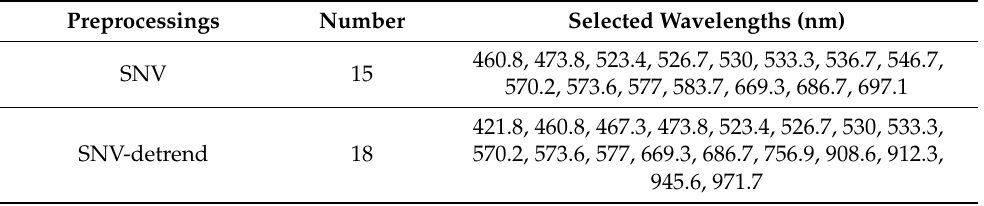
Table 6. The characteristic wavelengths selected by